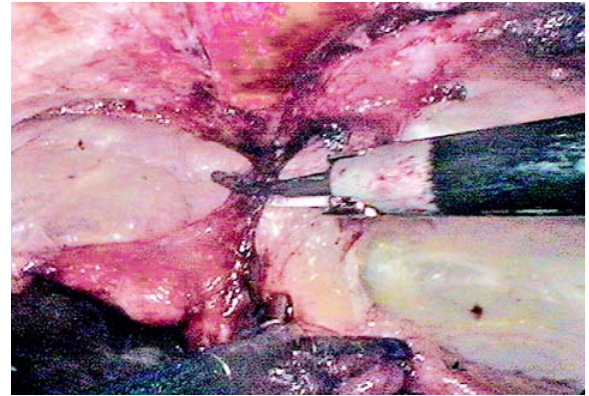
Figure 2 – Separation of the skin and the fibroareolar tissue that contains the lymph nodes, with the aid of a harmonic scalpel.